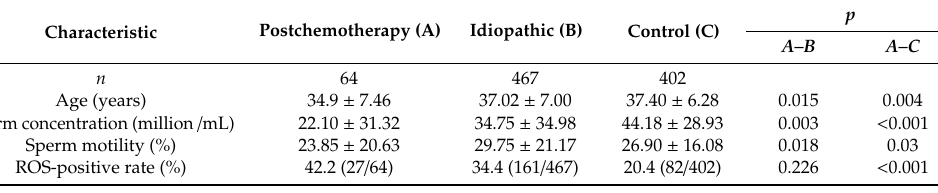
Table 1. Characteristics of patients and semen features in the three groups.